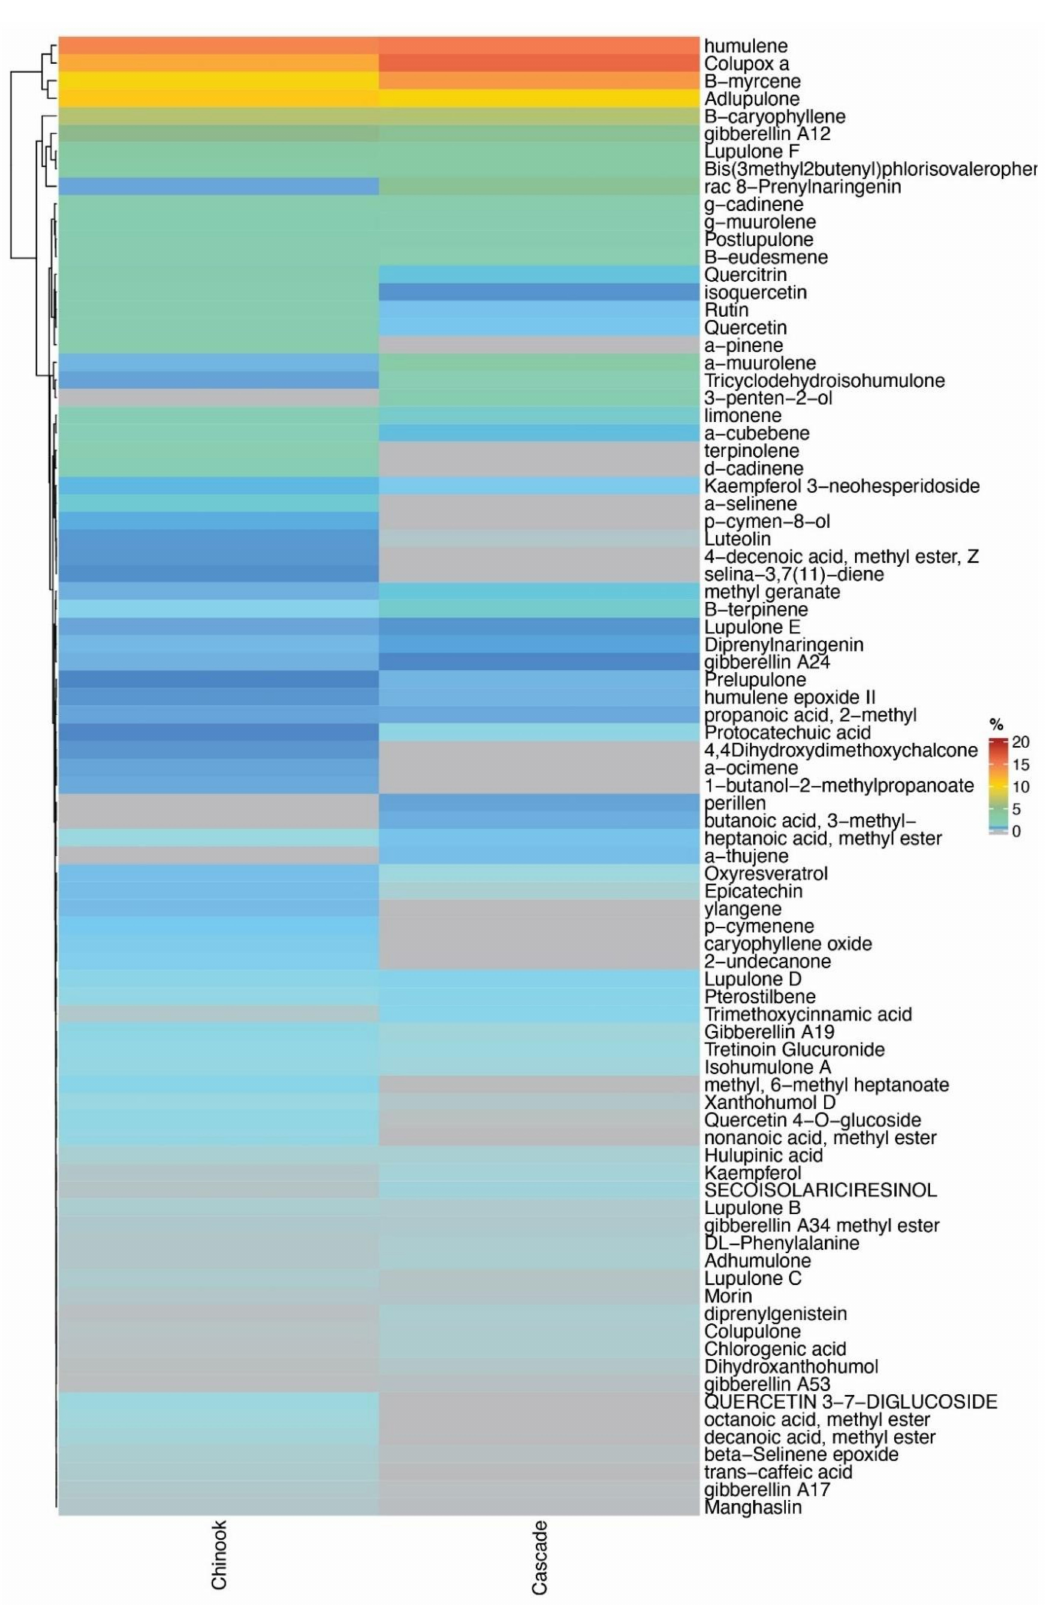
Figure 5. Heatmap of metabolite percentage normalized by sum in the inflorescence varieties of the two cultivars. Each cultivar is indicated in the column, and every row indicates a compound. Red indicates high abundance, whereas compounds under the detection threshold are in